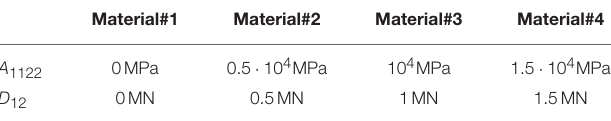
TABLE 3 | Mechanical properties used in Configuration 2 .